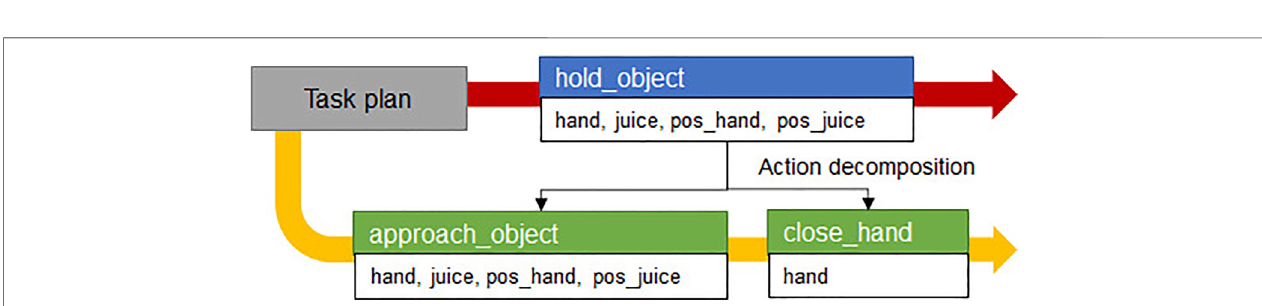
FIGURE 3 | Example of action decomposition. The red arrow is the fi rst planned compound action sequence from task manager and the yellow arrow is the primitive action sequence after the action decomposition.